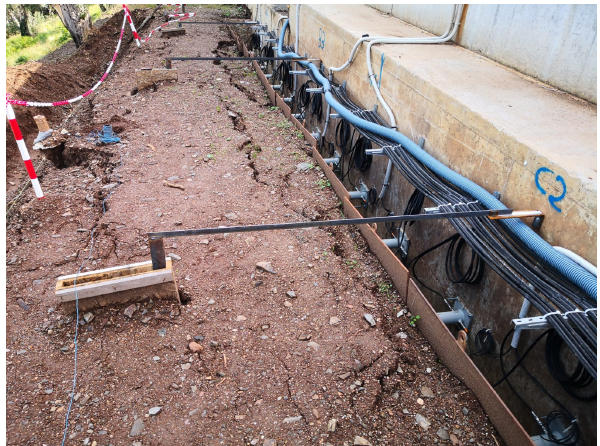
Figure 11. View of the marker